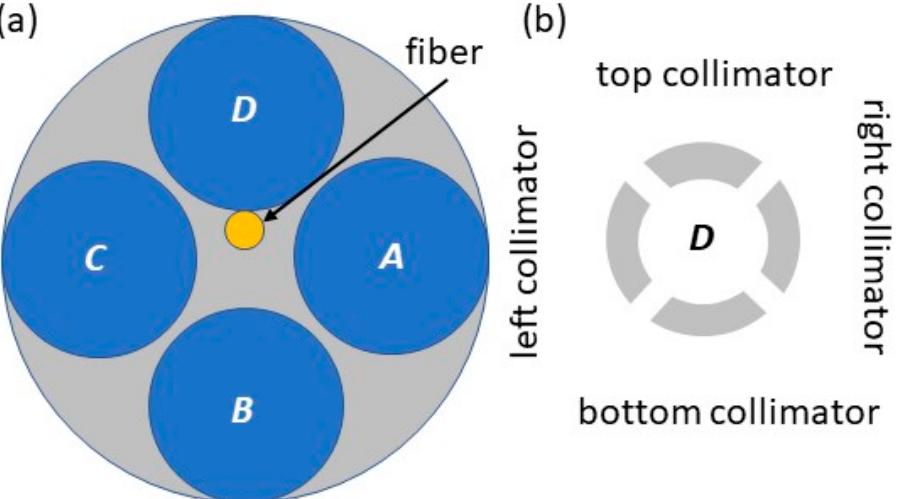
Figure 2. ( a ) Layout of the targets (blue) and fiber (yellow) in the inner position on the target selector (grey) looking upstream. Position A is housing a natural water target for the 16 O(p,a) 13 N production, position B is a natural thallium target for the 203 Tl(p,n) 203 Pb production, position C holds a target plug, and position D is an 18 O(p,n) 18 F gas target. ( b ) Quadrant collimators in front of target port D looking upstream. Each target position has its own quadrant collimator.